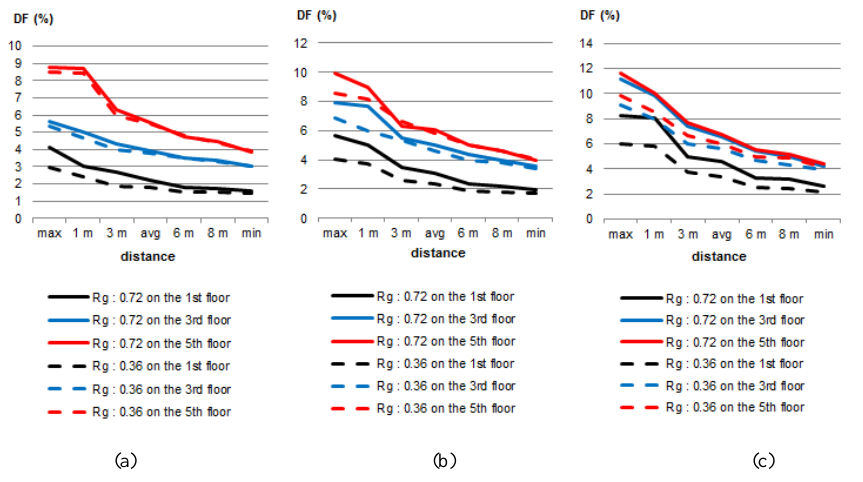
Fig. 7. DF of a 12 m wide room equipped with North-facing windows with light shelves with 2 variations in the ground reflectance in an urban area with 3 variations in aspect ratio, i.e. h / w = 4 and le / L = 0.25 (a), h / w = 2 and le / L = 0.25 (b), h / w = 0.75 and le / L = 0.25